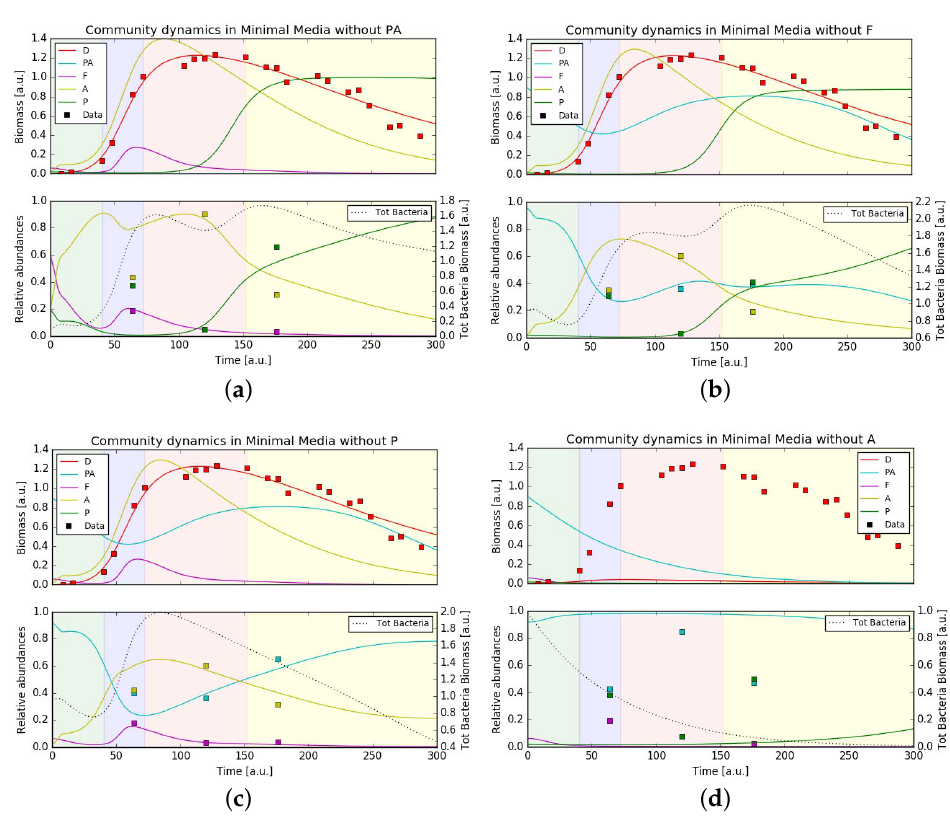
Figure 6. Reduced community simulation results (lines) and experimental data (squares) for communities of P. tricornutum ( D ), Pseudoalteromonadaceae ( PA ), Flavobacteriaceae ( F ), Alteromonadaceae ( A ) and Pseudomonadaceae ( P ) in minimal media conditions. Simulations are run removing from the bacterial community one member: ( a ) PA ; ( b ) F ; ( c ) P ; ( d ) A . The top panel shows the biomass time course (arbitrary units) for the four organisms and the rescaled data points (squares) for the P. tricornutum . The bottom panel shows the variations in relative abundances of the three bacteria (single bacteria biomass/total bacteria biomass) over time and the three sets of data points from the sequencing analysis (the first data point is used as starting condition at time 0). Also shown in the bottom plot (dotted line, right y -axis) is the total bacterial biomass in arbitrary